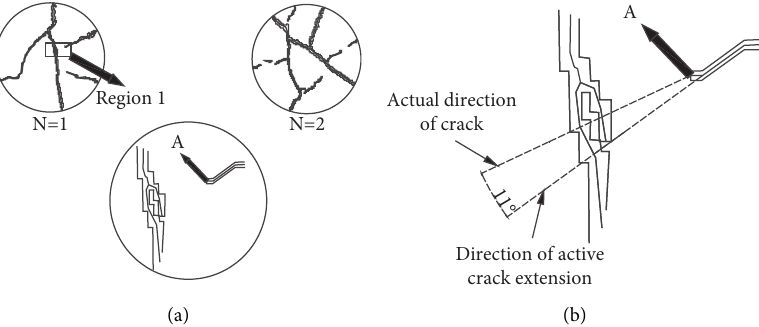
Figure 10: Schematic diagram of crack development in the first and second cycles. (a) Crack development of the whole specimen. (b) The relationship between active crack and passive